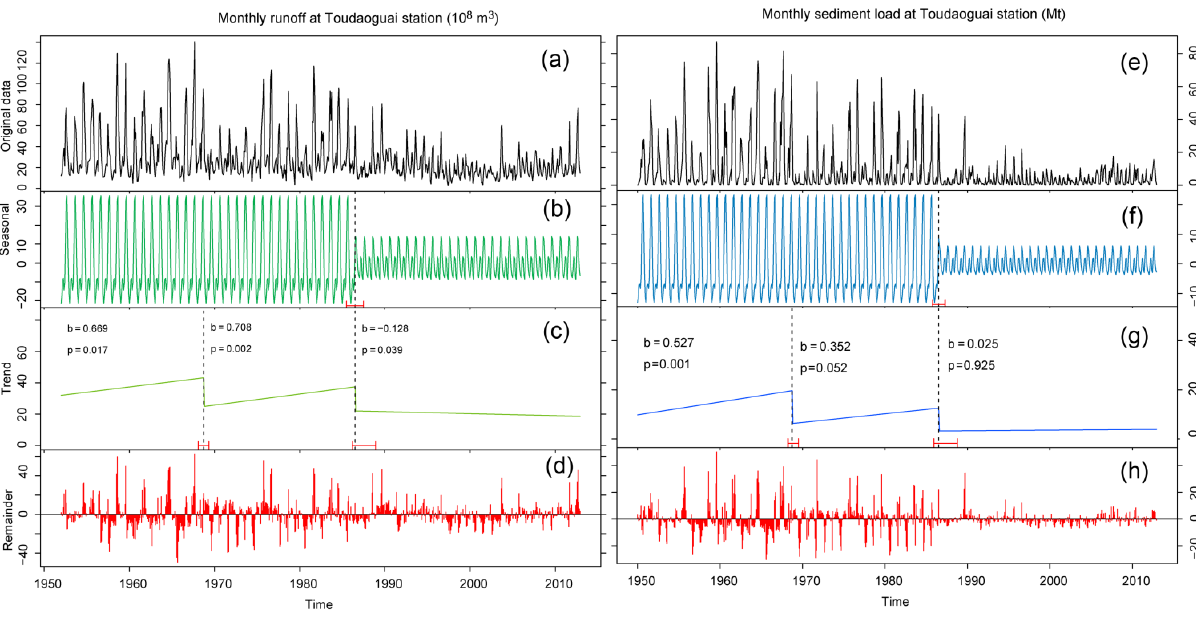
Figure 5. Monthly runoff and sediment load decomposition at the Toudaoguai